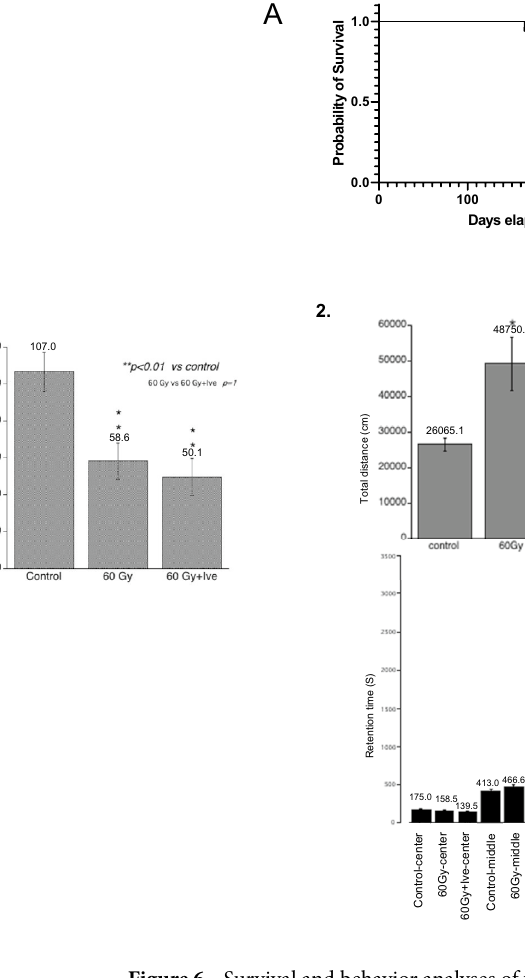
Figure 6. Survival and behavior analyses of the IVE-treated or non-treated brain RN model. ( A ) There was a slight, but non-significant, improvement in survival time in IVE-treated RN mice ( n = 15) compared with non- treated RN mice ( n = 17). ( B ) Results from cognitive tests among the non-irradiated control, non-treated RN, and IVE-treated RN groups ( n = 12 per group). 1. Rotarod test (25 rpm/min). 2. Open field test. 3. Y-maze test. ** P < 0.01, * P < 0.05 versus the non-irradiated control group, Bonferroni